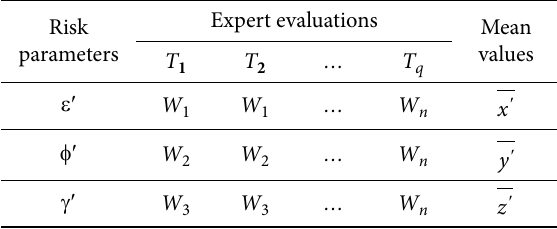
Table 3. Expert evaluations matrix Expert Risk parameters